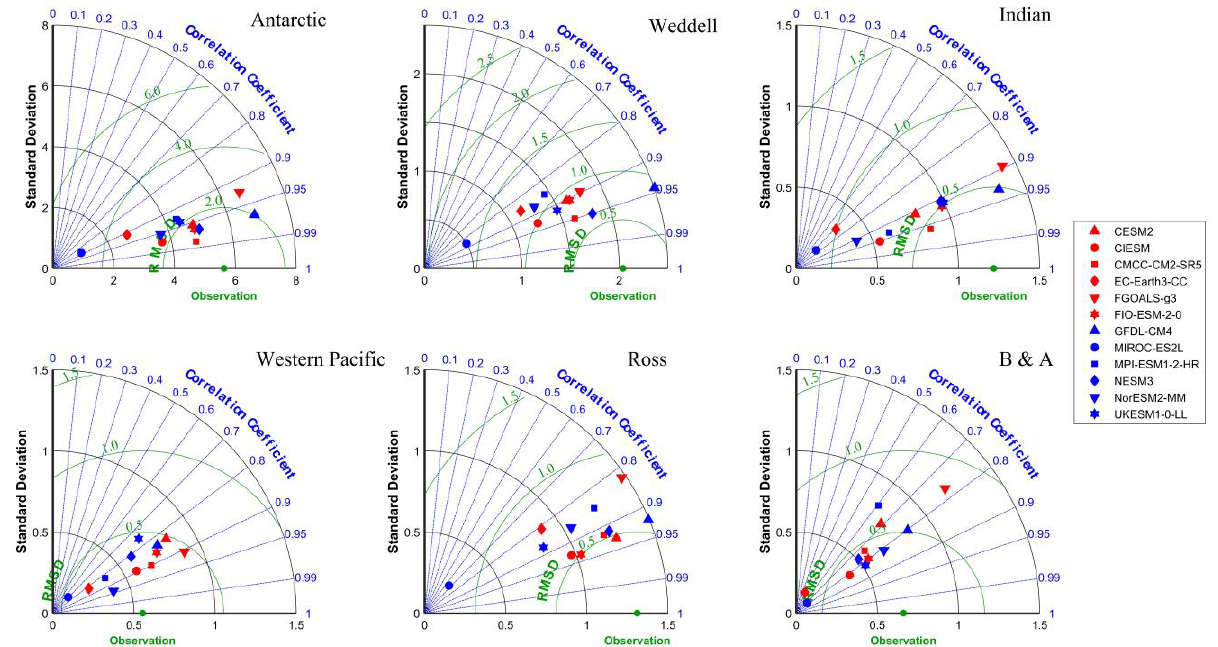
Figure 5. Taylor diagrams of SIA between the CMIP6 models and the observation in the whole Antarctic and five subregions over the period 2015–2021.